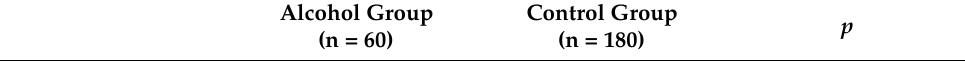
Table 2. Frequency of neurological signs related to acute alcohol consumption (dysarthria, ataxia, and eye movement disorder) before and after thrombolysis in cases (alcohol group) and